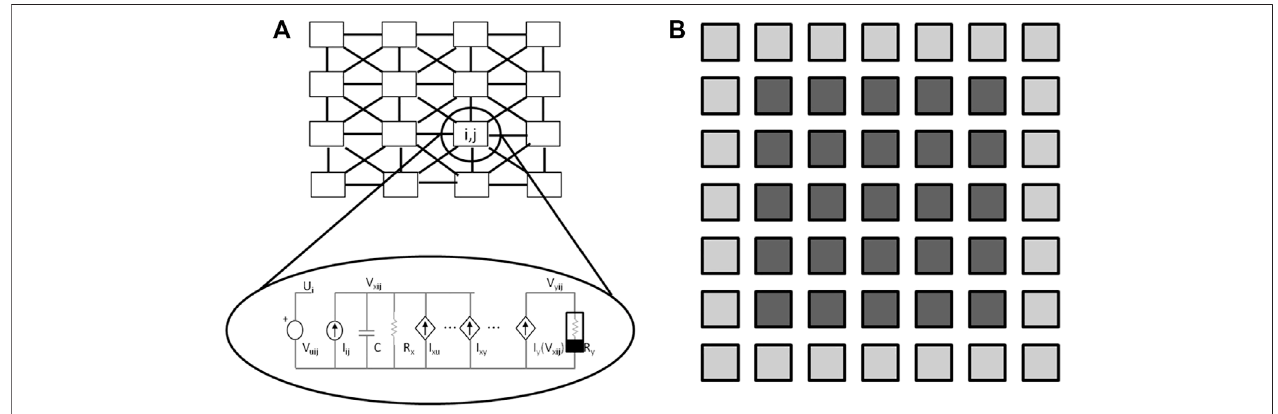
FIGURE 2 | Cellular Nonlinear Networks. (A) Each cell C ( i , j ) of the array is connected with its neighbors and realized by the nonlinear circuit shown in the inset. (B) Additional cells (in light gray) are used to represent the boundary conditions of the cells of a 5 × 5 CNN (in dark gray).